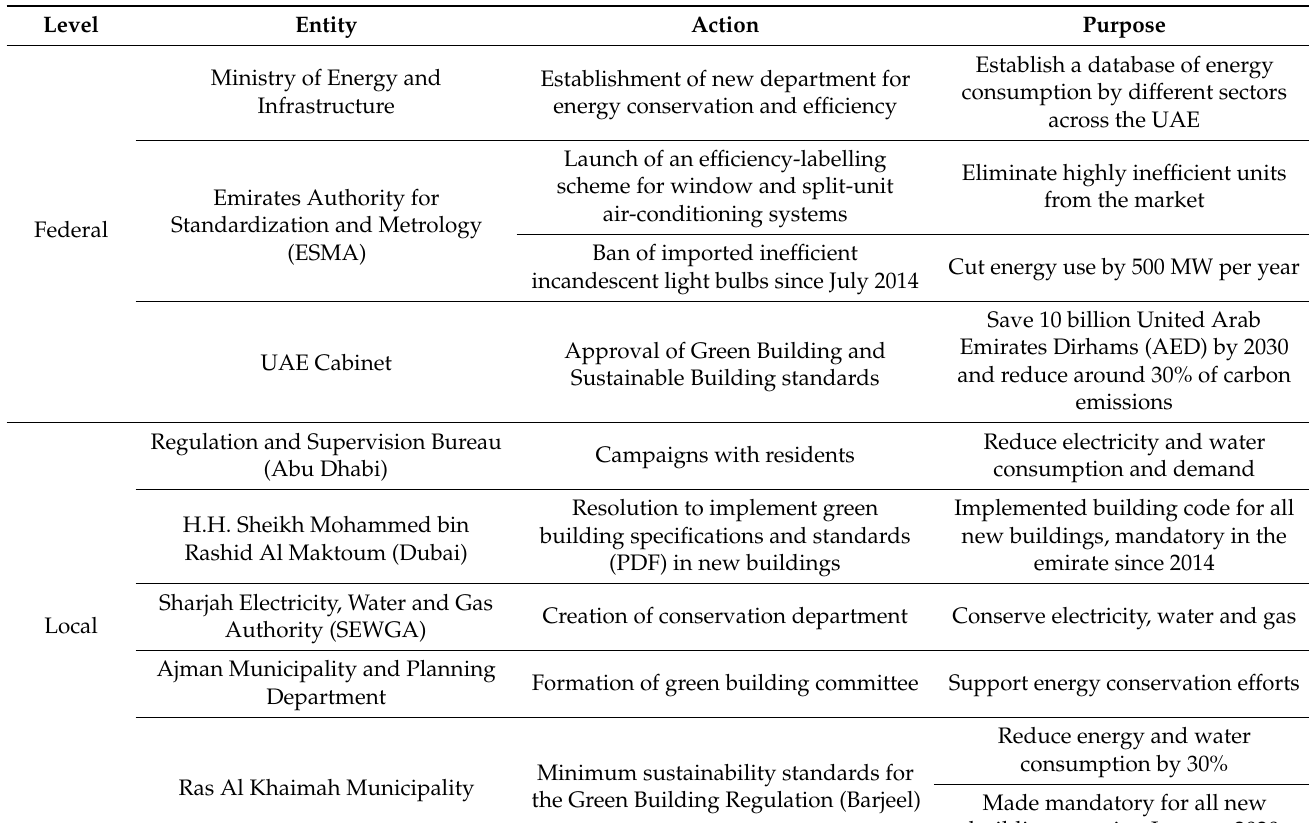
Table 2. Energy efficiency and conservation actions taken on the federal and local levels in the UAE